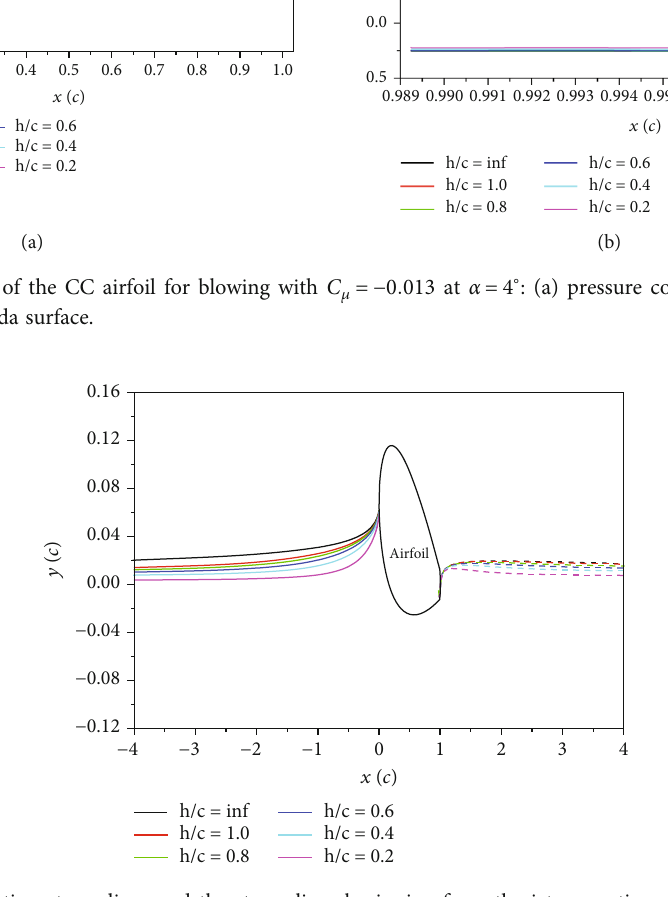
Figure 25: Leading edge stagnation streamlines and the streamlines beginning from the jet separation point on the Coanda surface for C = − 0 : 013 at α = 4 ° μ